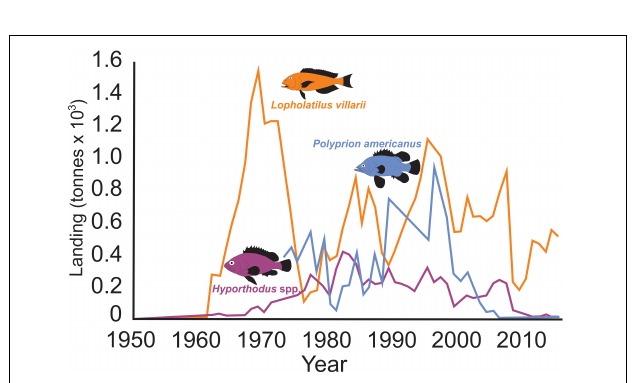
FIGURE 7 | Landing for three selected taxa of demersal fishes in southeastern-southern Brazil (1950–2015).